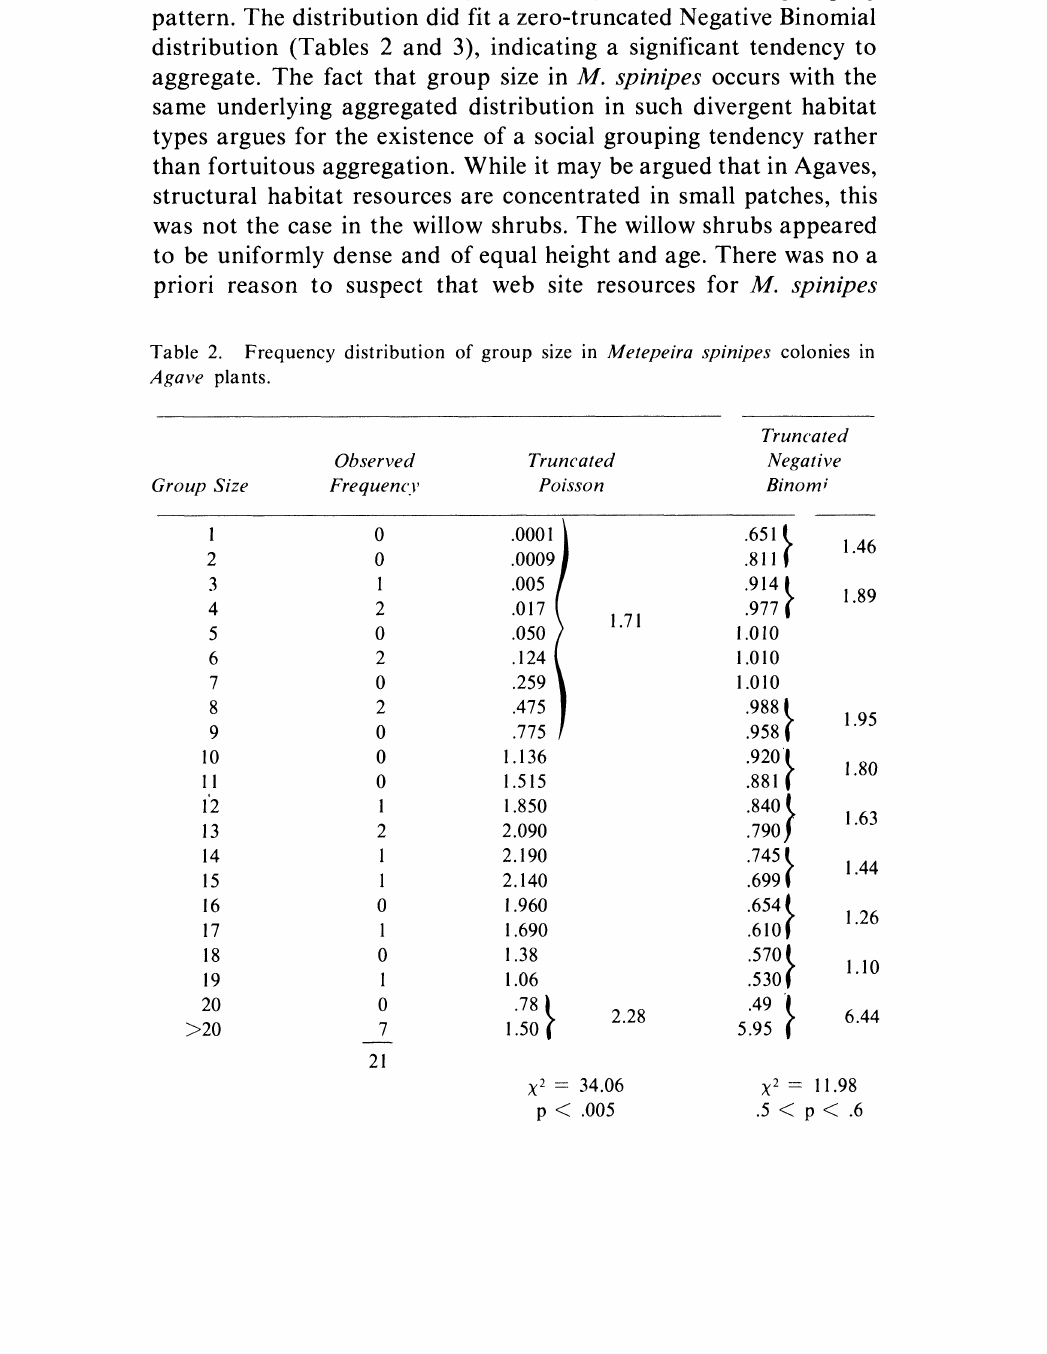
Table 2. Frequency distribution of group size in Metepeira spinipes colonies in Agave plants. Observed